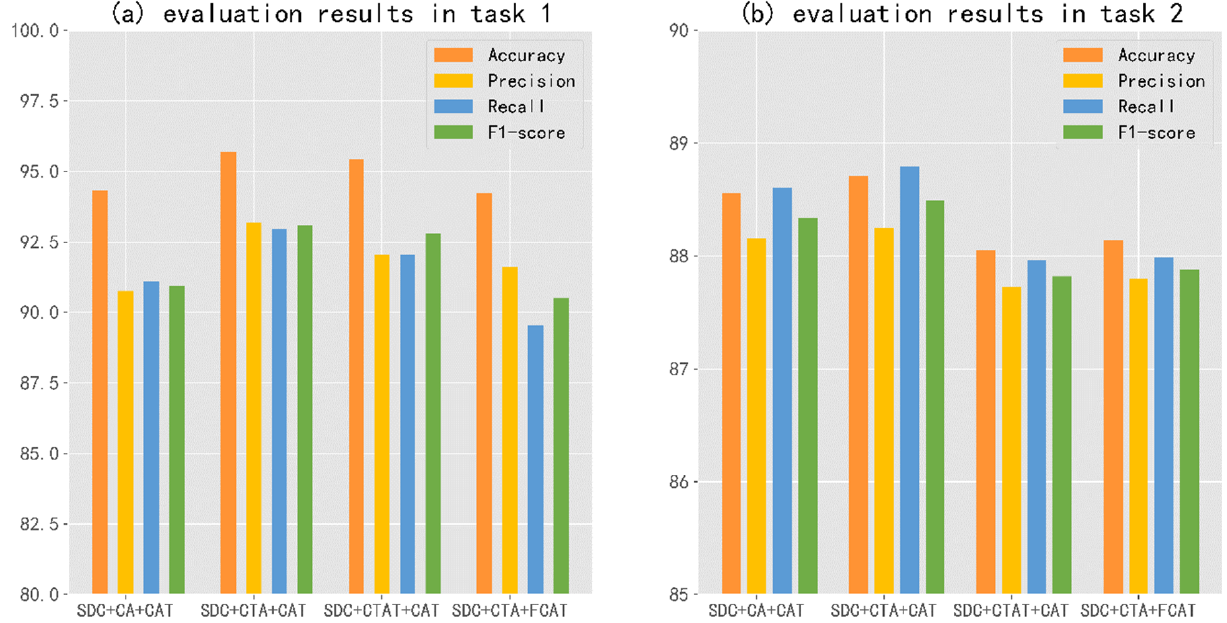
Figure 9. Comparisons of accuracy, precision, recall, and F1 ‐ score of the model on Dataset B for task 1, malware detection, and task 2, malware family classification. (a) evaluation result in task 1.(b) evaluation result in task 2.